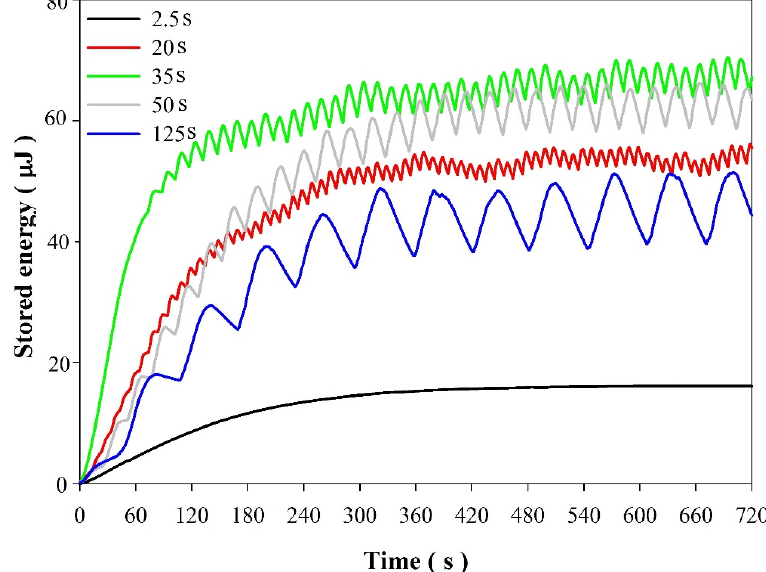
Figure 10. Relationships between the stored energy in the 10 μ F electrolytic capacitor and times of various periods for the PZT pyroelectric harvester with temperature fluctuations in the range from 65 °C to 75